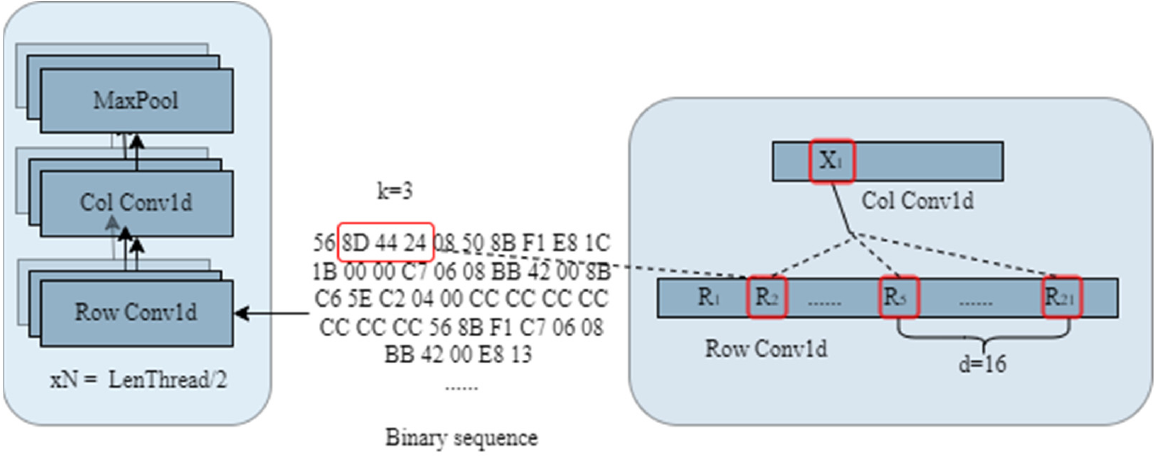
Figure 2. Stacked convolution network. A linear layer turns binary to a vector b . A convolutional layer represents multiple binary ( b i : n = b i , . . . , b n ) as feature R i , while a dilation convolution layer is applied to extract binary of different position. The pooling layer further refines features.